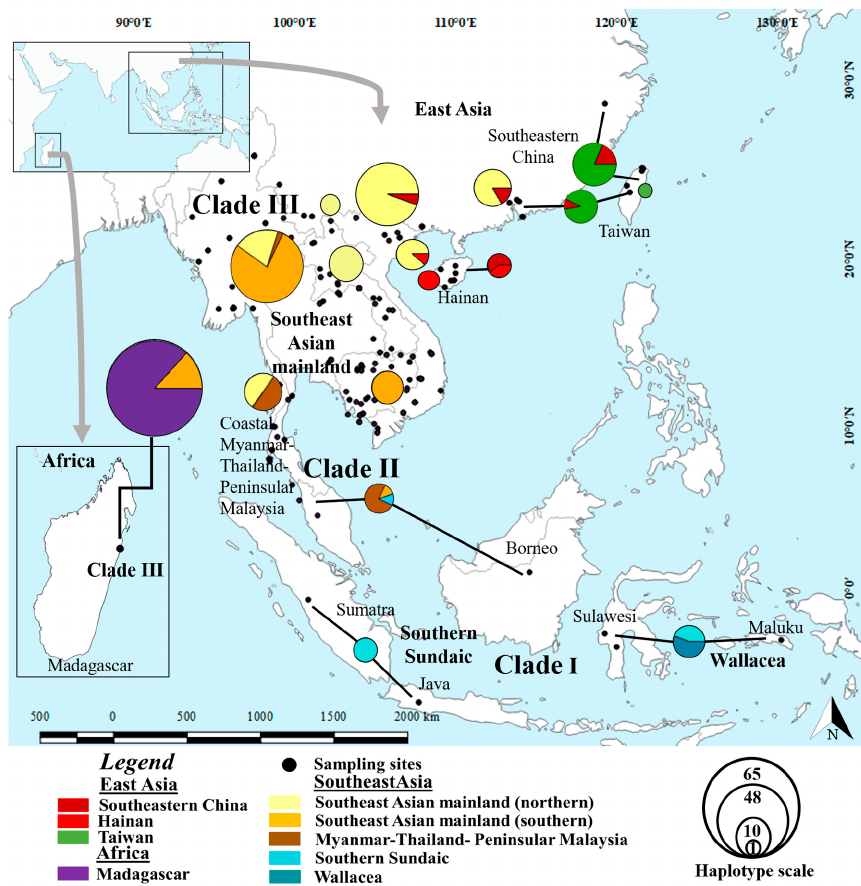
Figure 1. Haplotype networks built from 363 Duttaphrynus melanostictus individuals inferred from 336 bp of tRNAGly ND3 mtDNA fragments. The size of the pie-charts is proportional to the number of samples represented by each haplotype. The symbols and colours used in the legend correspond with those on the haplotype network.